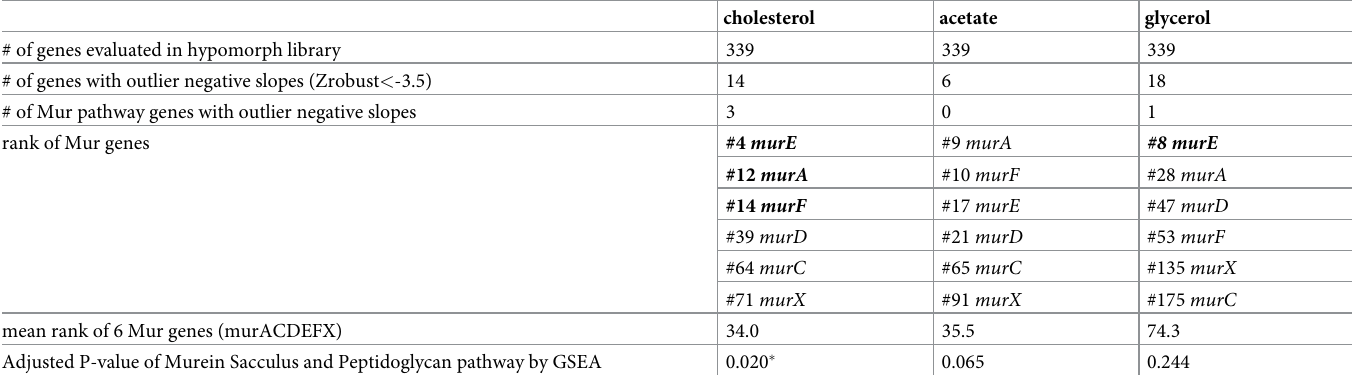
Table 5. Analysis of C-G interactions for copper